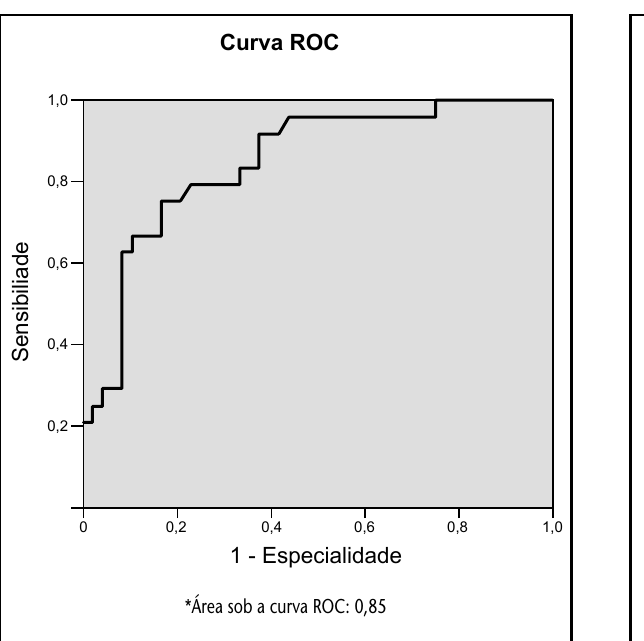
Figura 1 – Curva ROC desenvolvida para o parâmetro índice APRI Figura 2 – Curva ROC desenvolvida para o parâmetro ácido